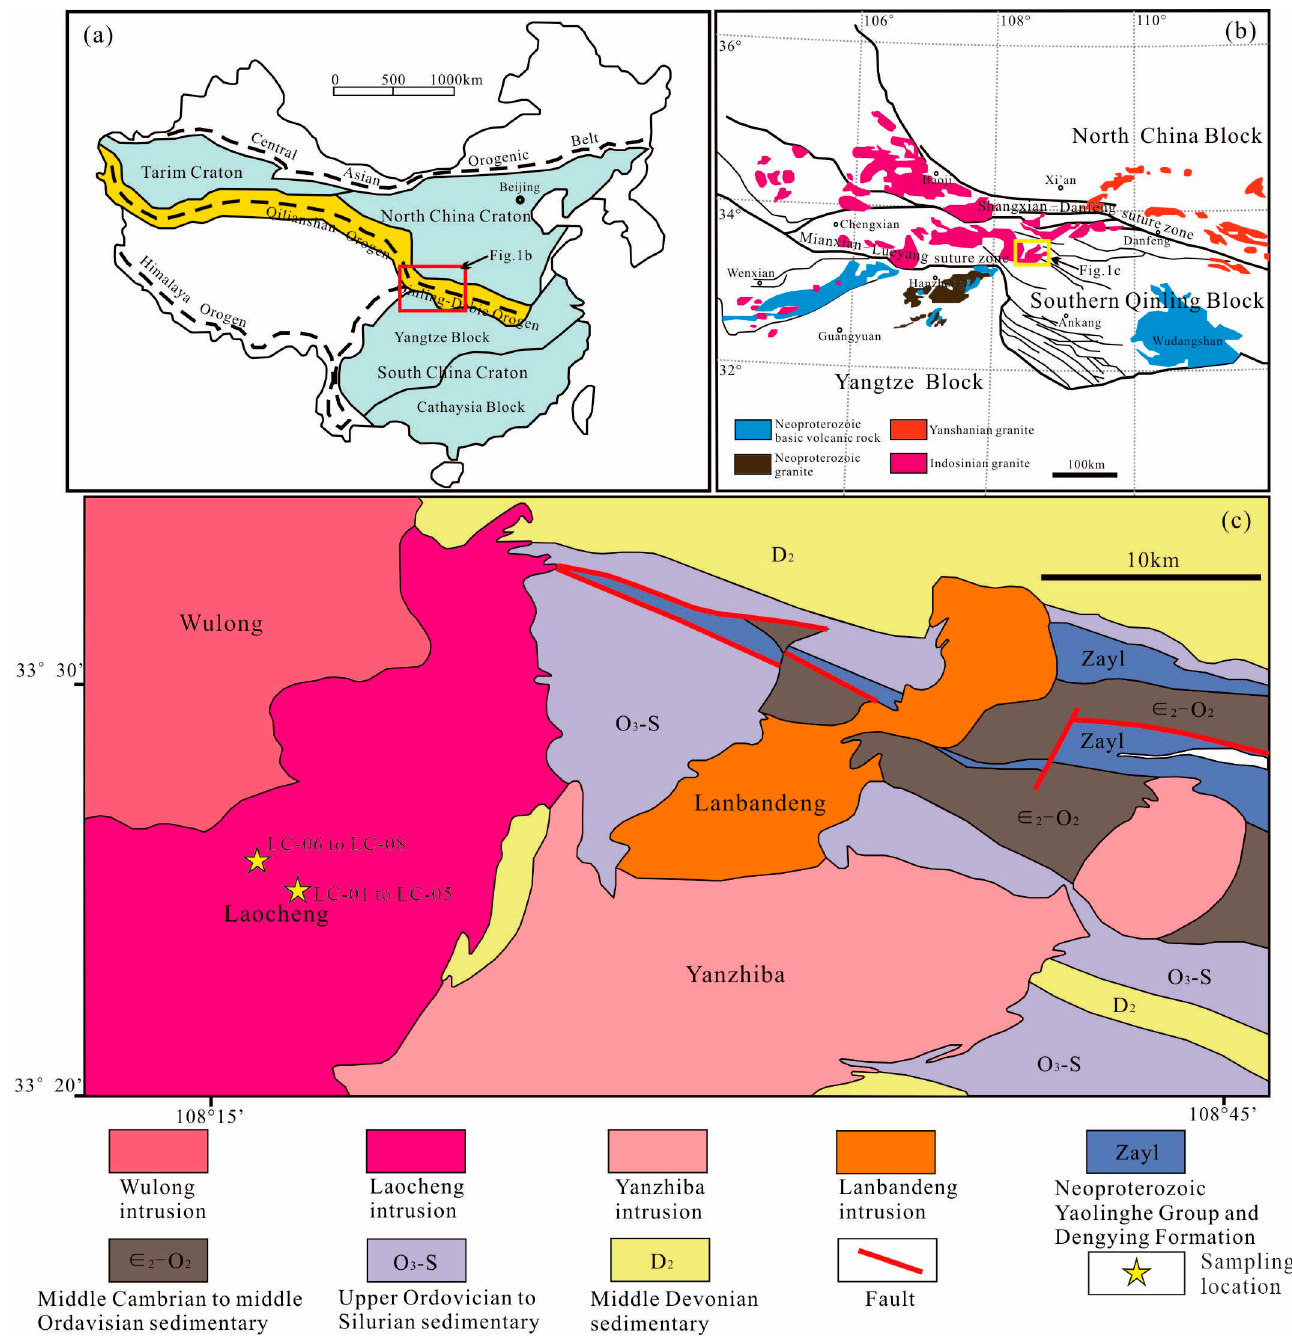
Figure 1. ( a ). Sketch Geological map of China, ( b ) geological map of the Qinling Orogenic belt and ( c ) the geological map of the Triassic Laocheng and Yanzhiba pluton. The Laocheng pluton locates to the east of the Triassic Wulong composite pluton, which covers an area of ~24 km 2 (Figure 1b). The Laocheng pluton intrudes into Neopro- terozoic—Ordovician quartzite, Cambrian-Ordovician graphite-quartzite and Silurian micaceous quartzite. The appinite occurs as mafic blocks (varying from several meters in size) that are enclosed by Laocheng granite; some granitic veins can be observed in the appinite (Figure 2a). Eight appinite samples were selected from the Laocheng village, 10 km to the north of Ningshan City (Figure 1c). The appinite is medium–grained (Figure 2), and consists of euhedral hornblende (50%~60%) and plagioclase (20% to 25%; An 40–45 ) with minor quartz (<5%) and biotite (5%~10%). The euhedral hornblende grain has a large size